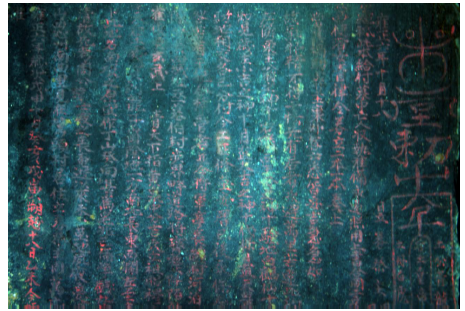
Figure 1. True color image combined by hyperspectral